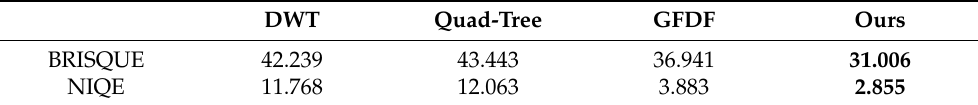
Table 4. Blind image quality evaluation results for second dataset of conjunctival goblet cell images.